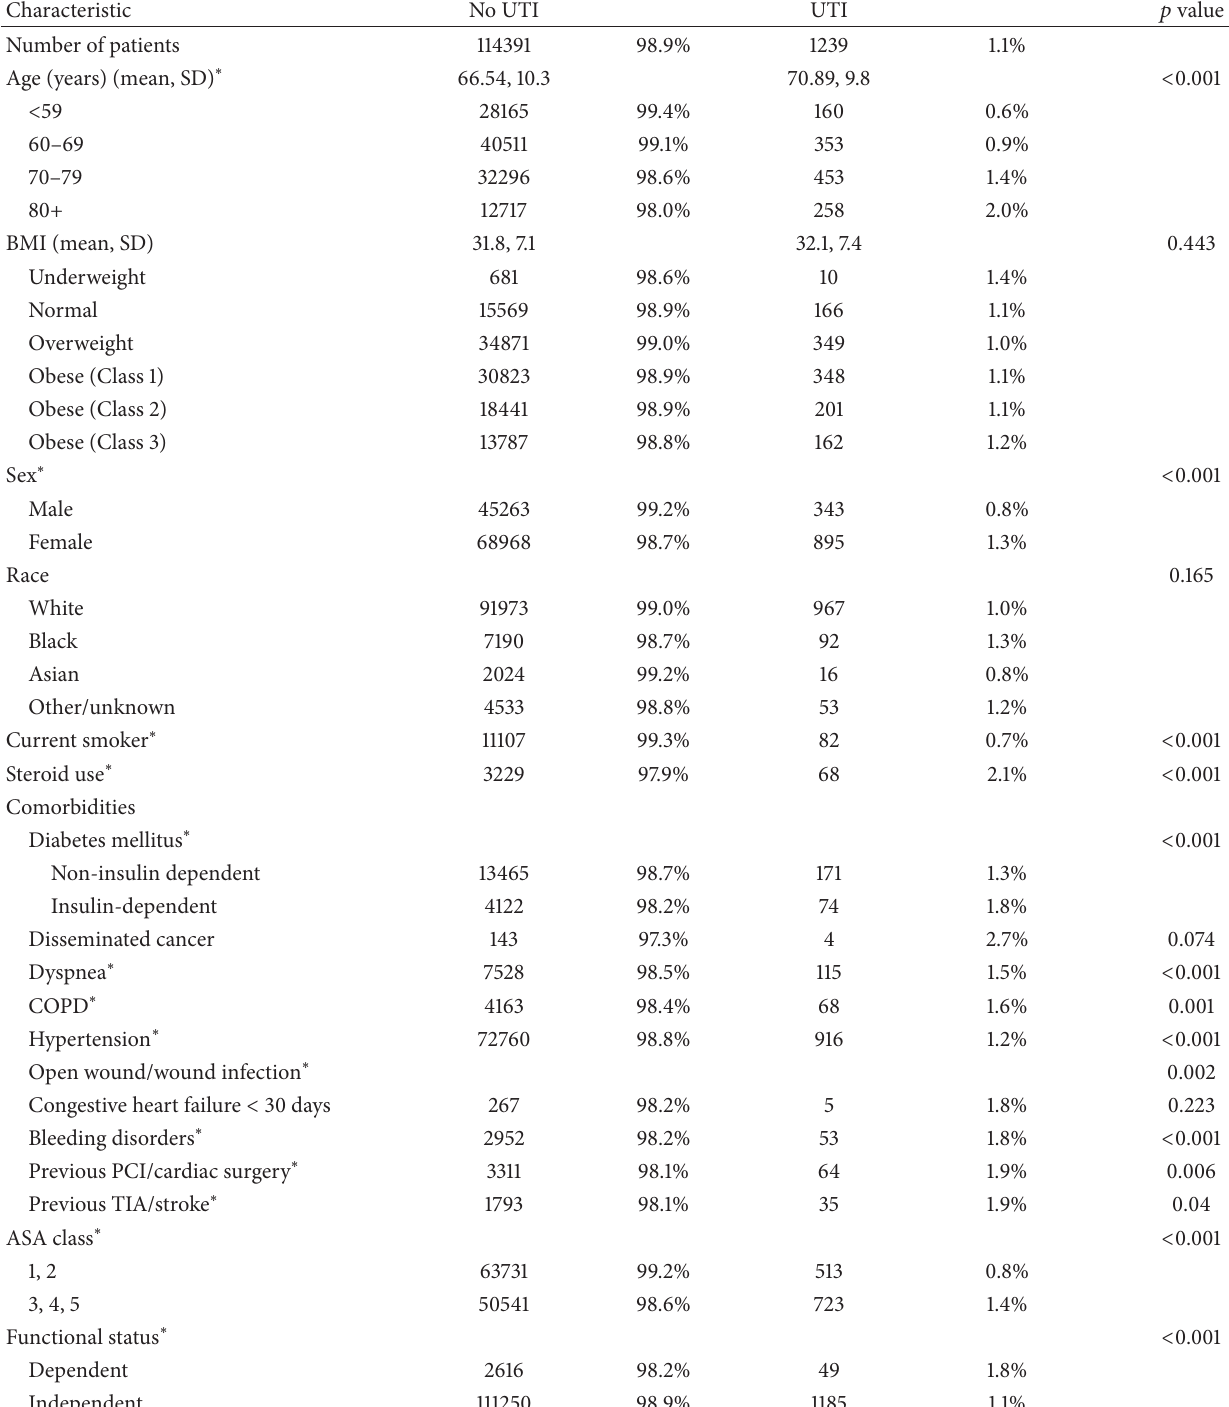
Table 1: Preoperative